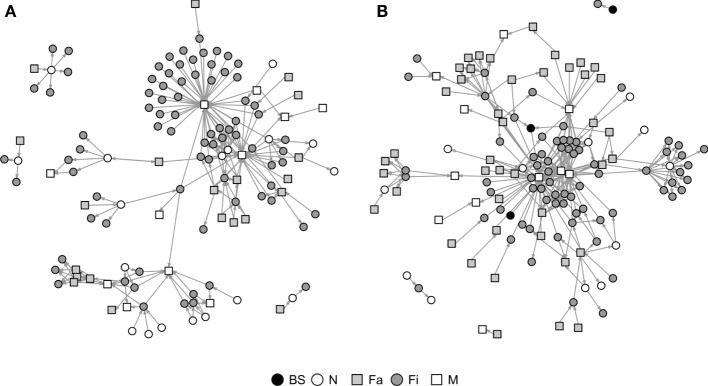
Graphical representation of Rice (A) and Stevens networks (B). Circles and squares represent either swine farms (BS, boar stud; Fa, farrowing; N, nursery; and Fi, finishing) or market sites (M).